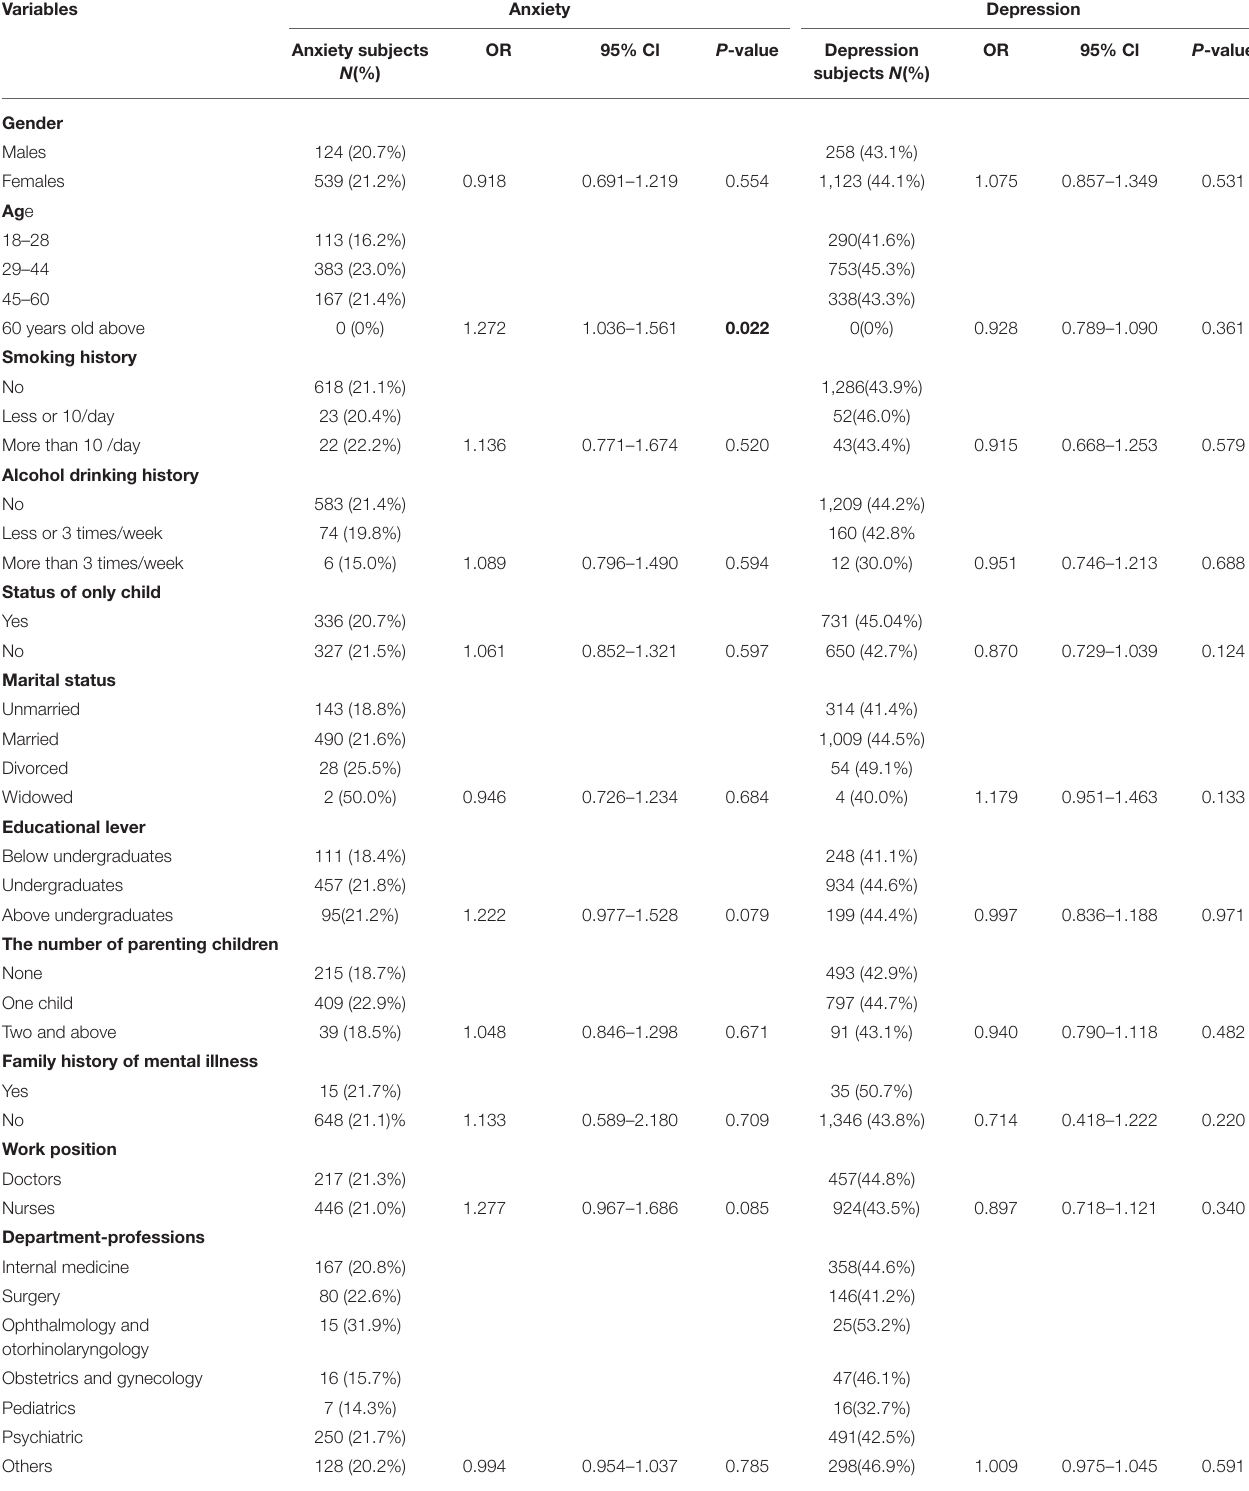
TABLE 4 | Multiple logistics analysis of independently related factors of anxiety and